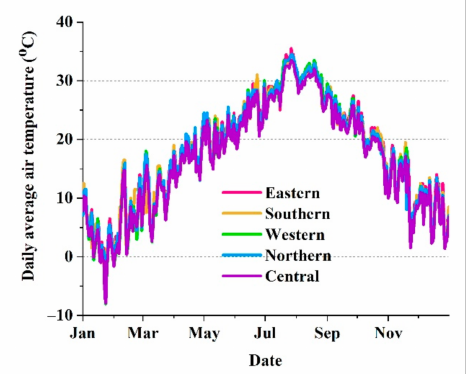
Figure 4. Daily average air temperatures during 2016 at the eastern (Suzhou), southern (Huzhou), western (Yixing), northern (Wuxi), and the central weather stations of Lake Taihu (see Figure 1b).